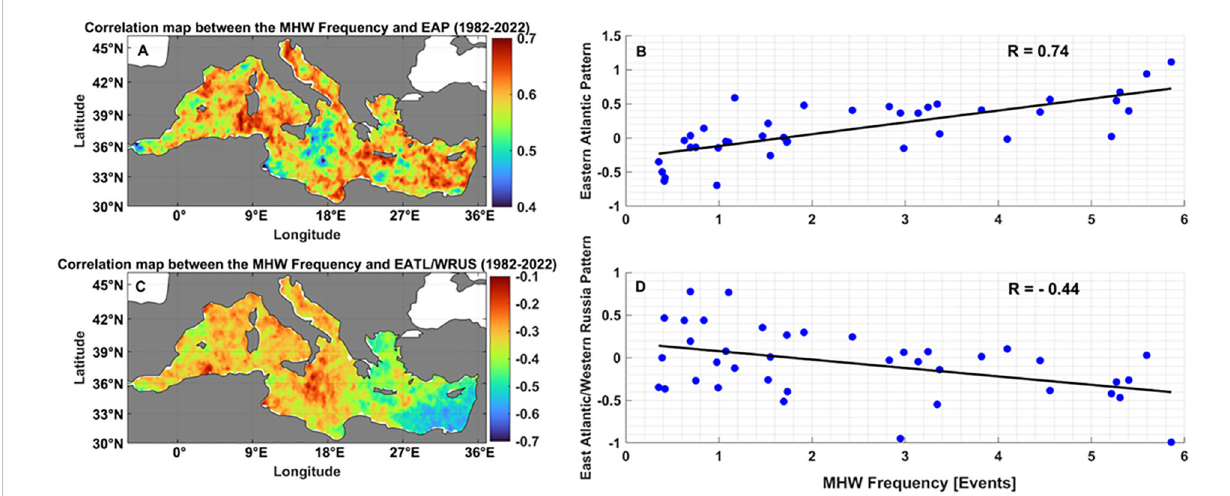
FIGURE 5 The relationship between annual MHW frequency and teleconnection patterns over the Mediterranean Sea from 1982 to 2020. The correlation map between MHW frequency and Eastern Atlantic pattern (A) and the scatter plot between them (B) . The correlation map between the MHW frequency and the East Atlantic/West Russian pattern (C) and the scatter plot between them (D) .